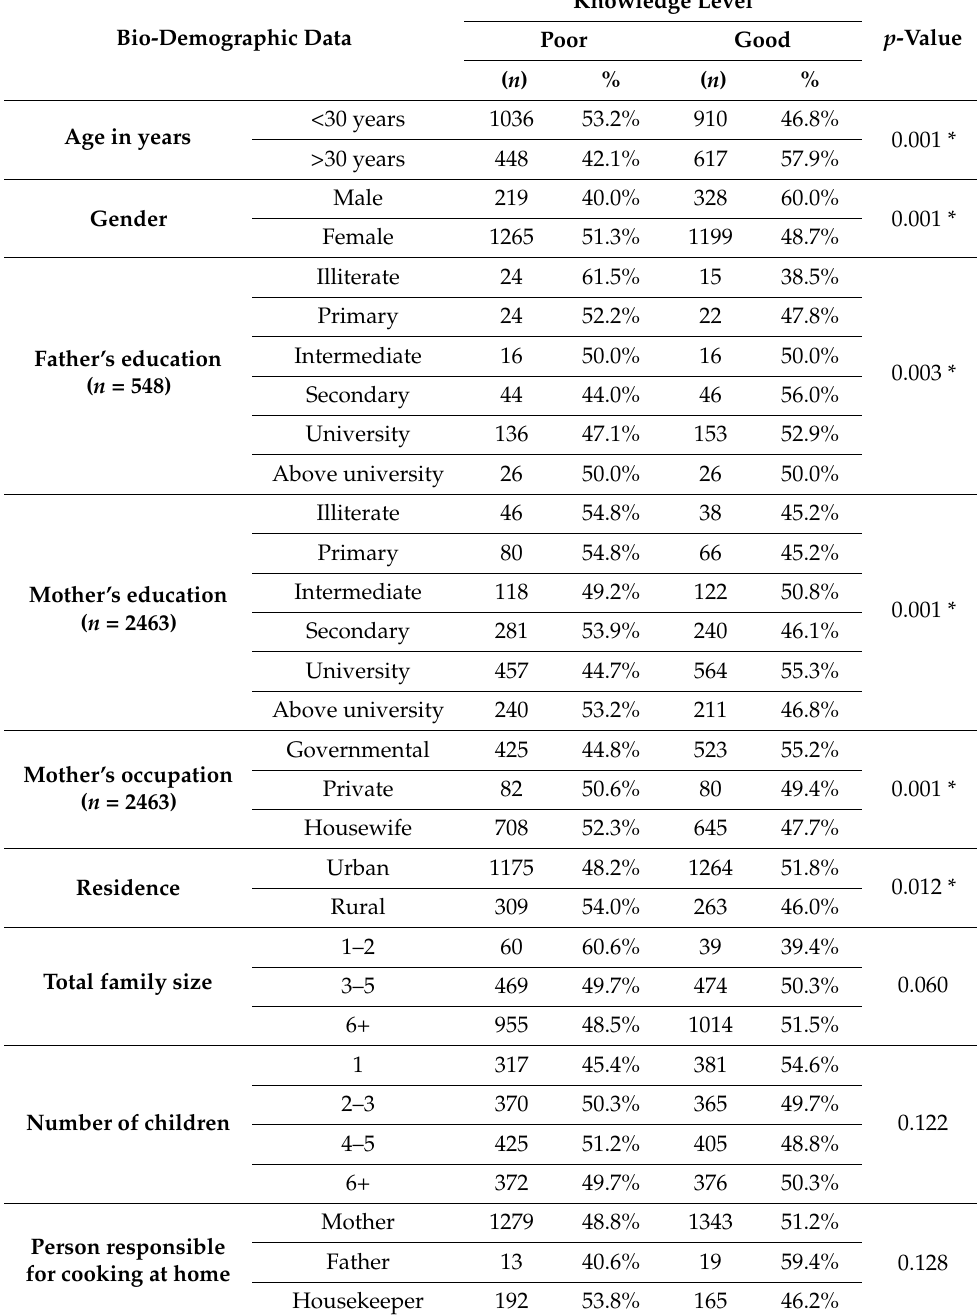
Table 5. Distribution of parents’ knowledge regarding food poisoning by their bio-demographic